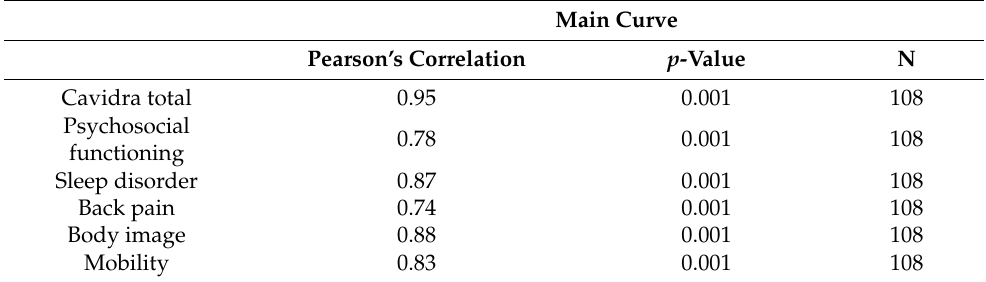
Table 5. Values of Pearson’s correlation between degrees of main curve and Cavidra scale values. Main Curve Pearson’s Correlation p -Value N Cavidra total 0.95 0.001 108 Psychosocial 0.78 functioning